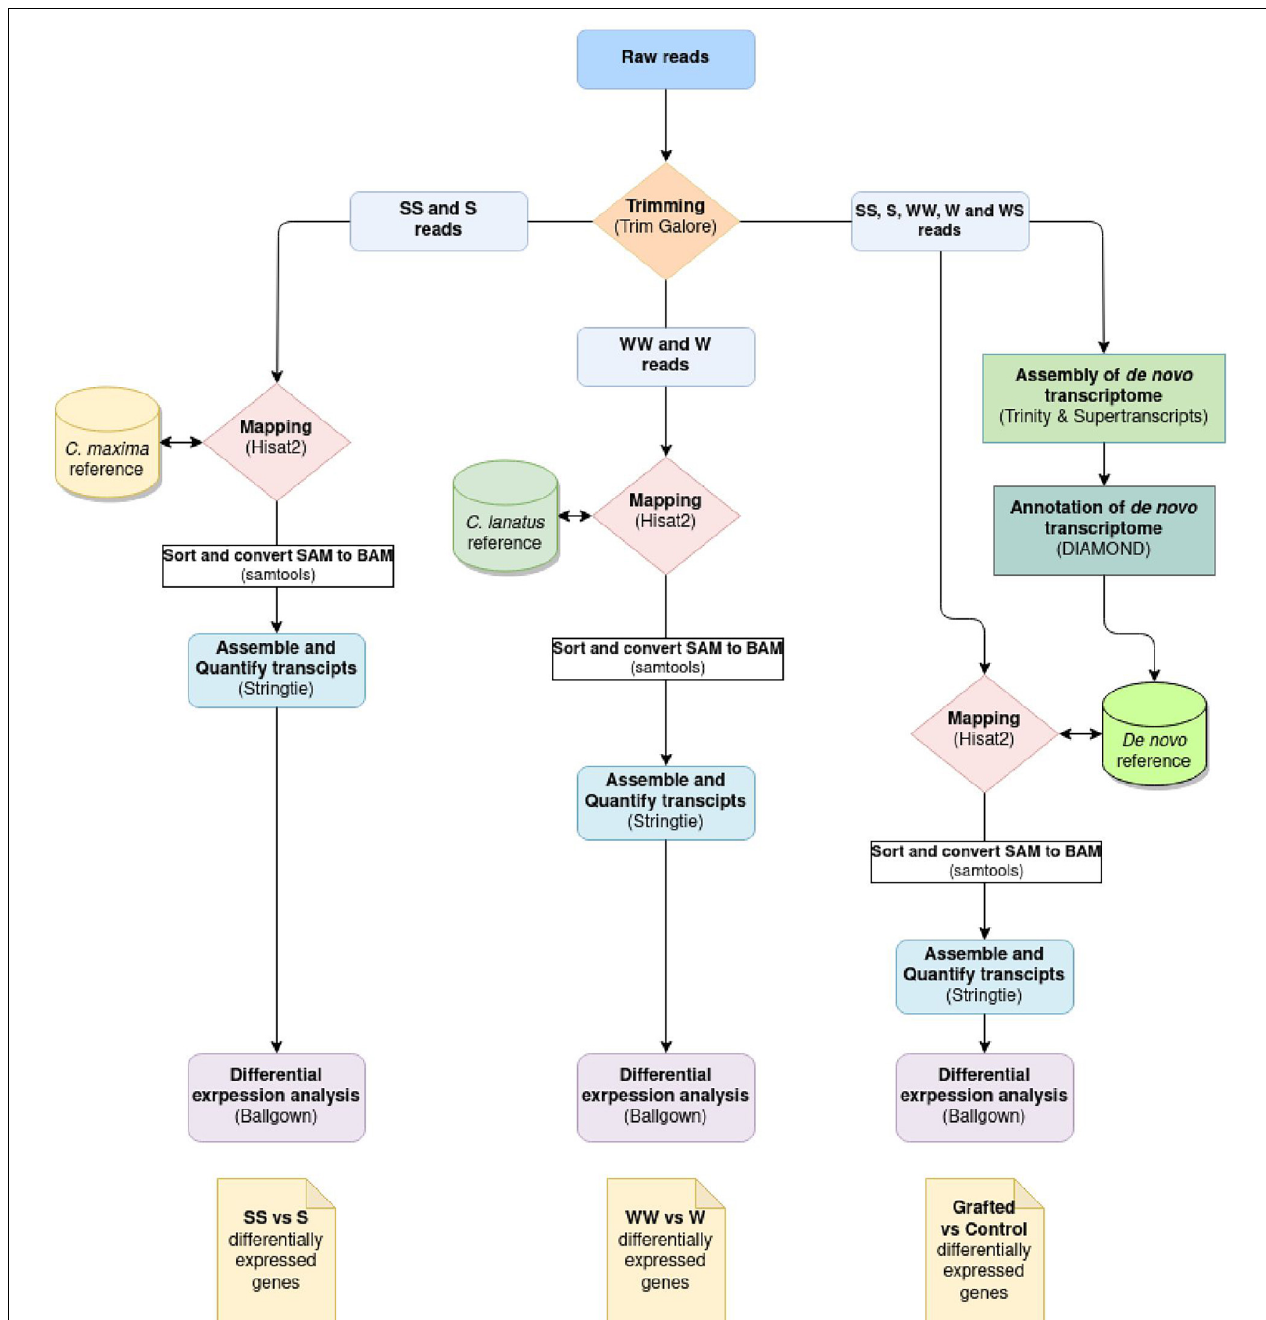
FIGURE 2 | Differential expression analysis workflow. The same workflow was followed for all the three comparisons, which differ only at the reference used for the mapping of the